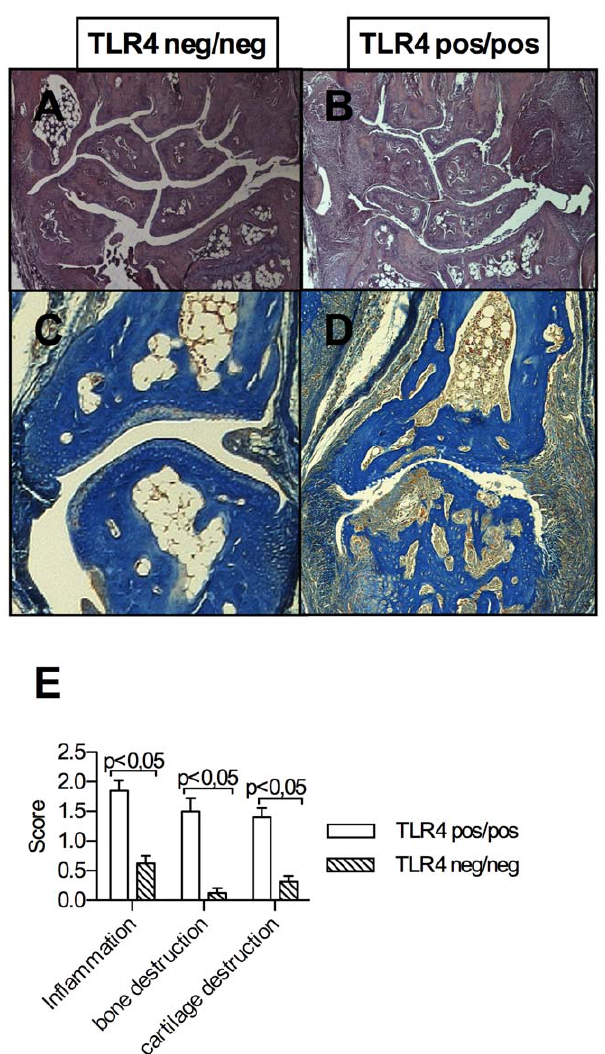
Figure 2. Histological joint destruction in paw sections. Synovial inflammation is suppressed in CIA in DBA1J TLR4 negative mice (A, C) compared to wt mice (B, D). Representative front paw sections showing wrist and carpal joints and stained in H&E, original magnification 6 10 are shown in (A) and (B) and interphalangeal joints with extensive pannus formation and bone destruction stained with Nuclear Fast Rubine-Aniline Blue-Orange G in (C) and (D), original magnification 6 100. Histological joint scores reflecting significantly suppressed inflammation and cartilage and bone destruction in TLR4 defective mice are shown in (E).